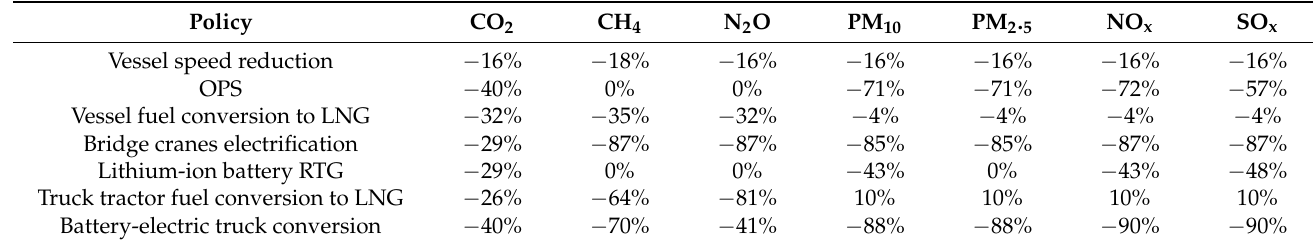
Table 4. The effect of each reduction